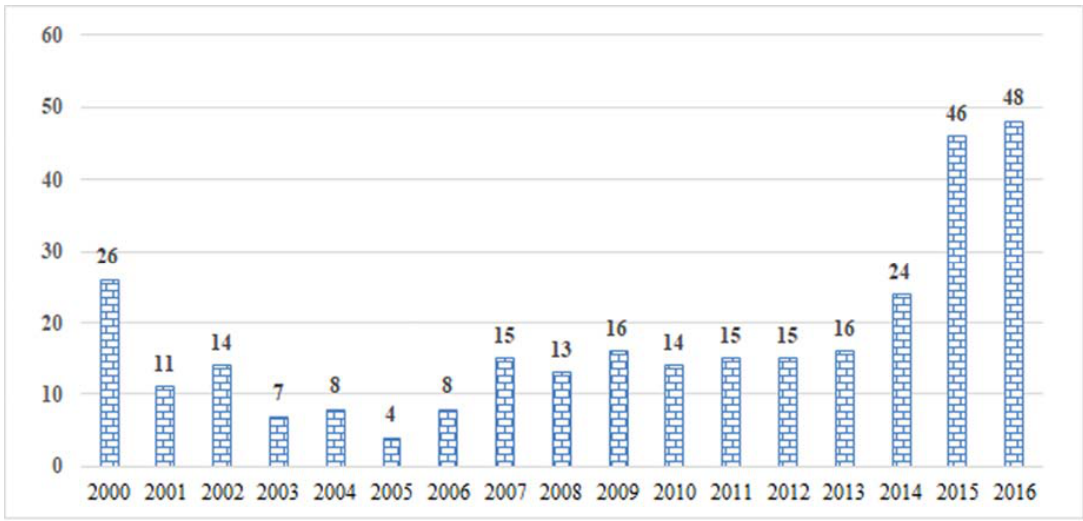
Figure 6. Annual distribution of TOP 300 burst keywords.